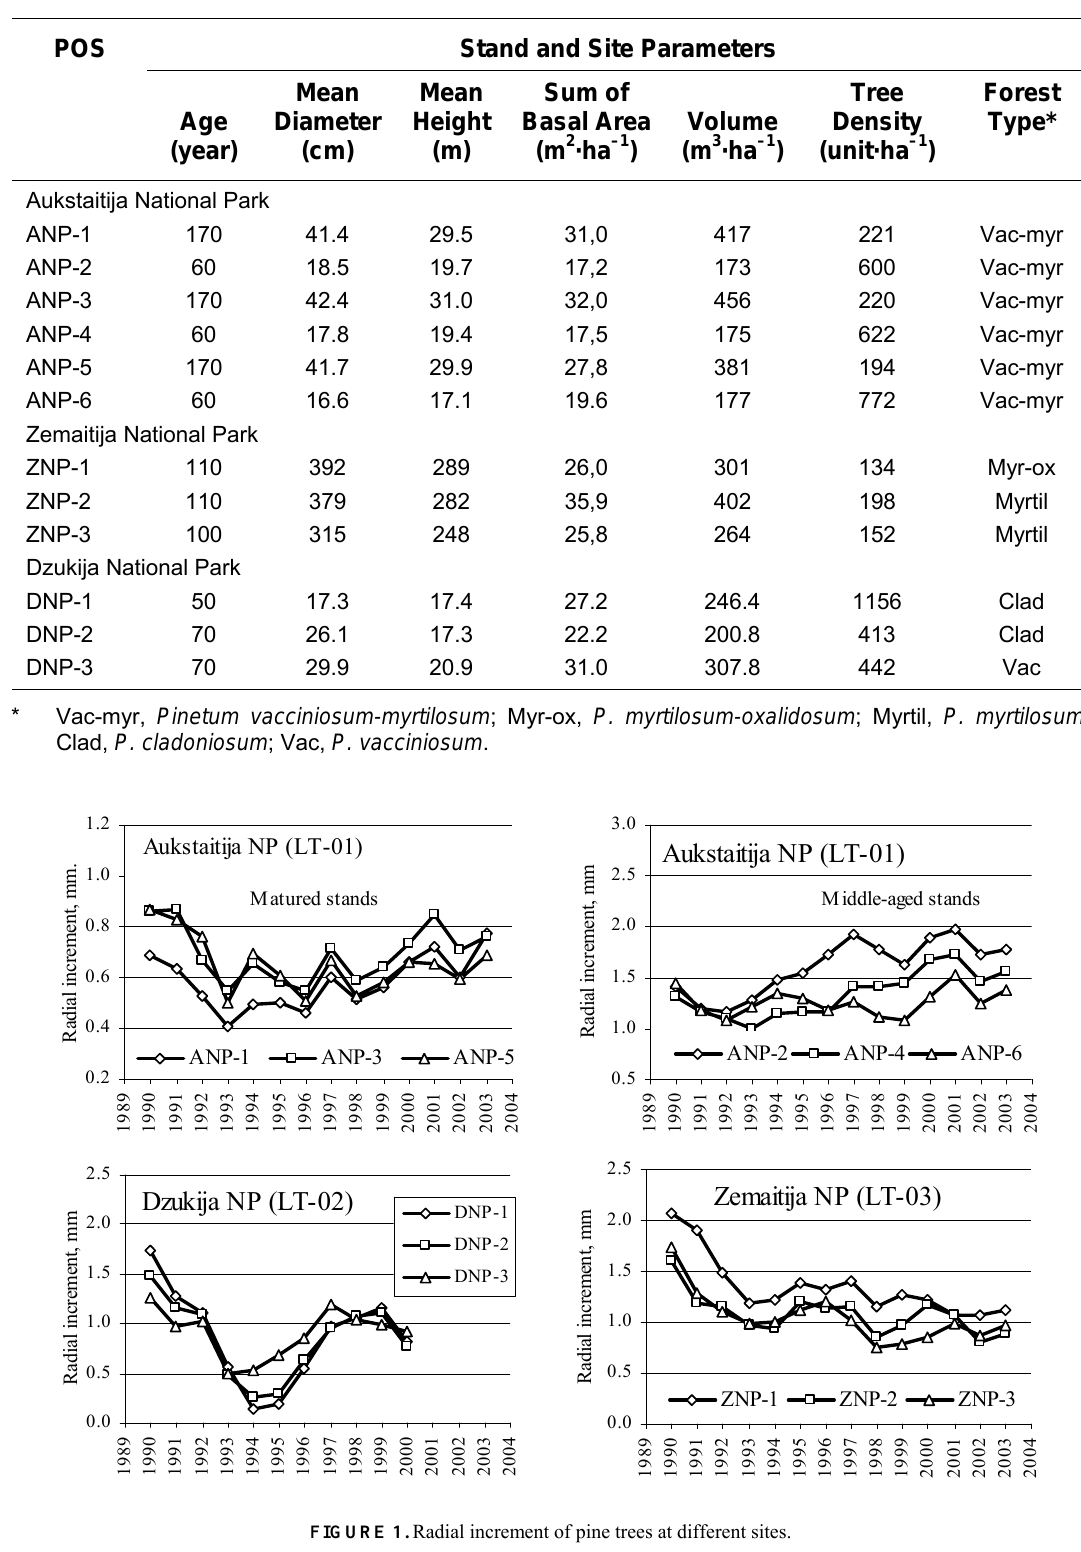
FIGURE 1. Radial increment of pine trees at different